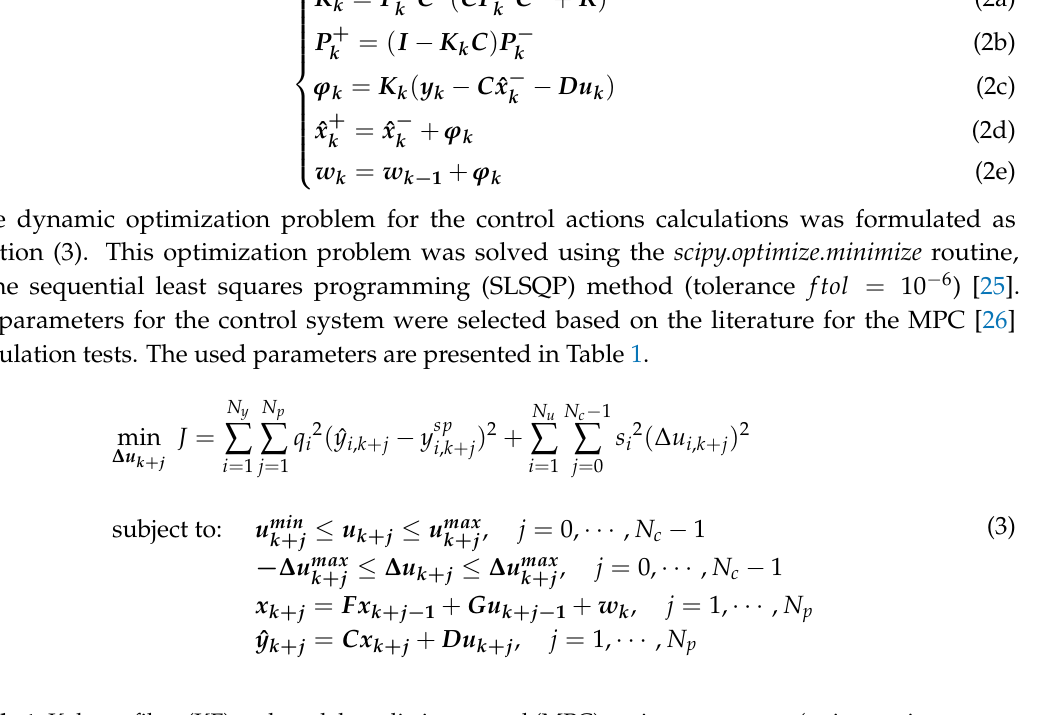
Table 1. Kalman filter (KF) and model predictive control (MPC) tuning parameters (units consistent with values of Tables A2 and